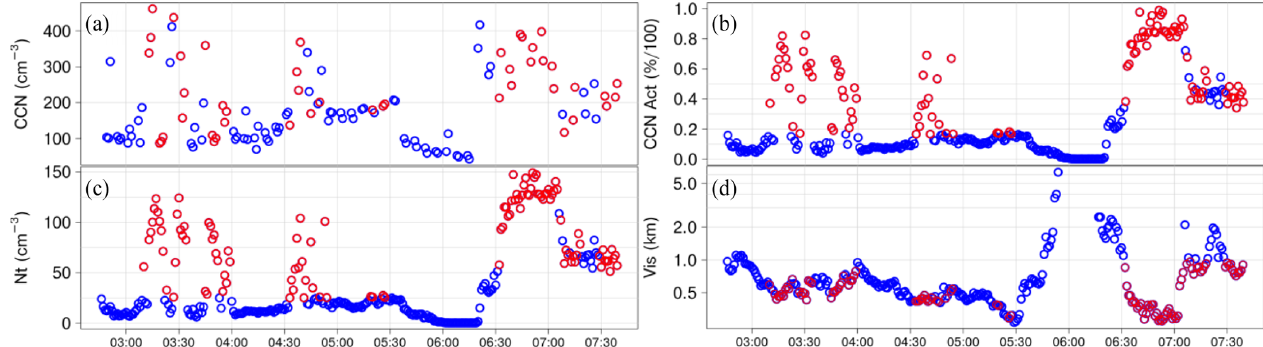
Figure 6. Time series of (a) CCN (cm − 3 ), (b) N t (cm − 3 ), (c) activated CCN (proportion), and (d) visibility during the fog event on 9 September 2017. Red dots indicate data points used to calculate activated CCN. Blue dots are not used to calculate activated CCN and are shown for context. Times are in UTC (site is UTC +